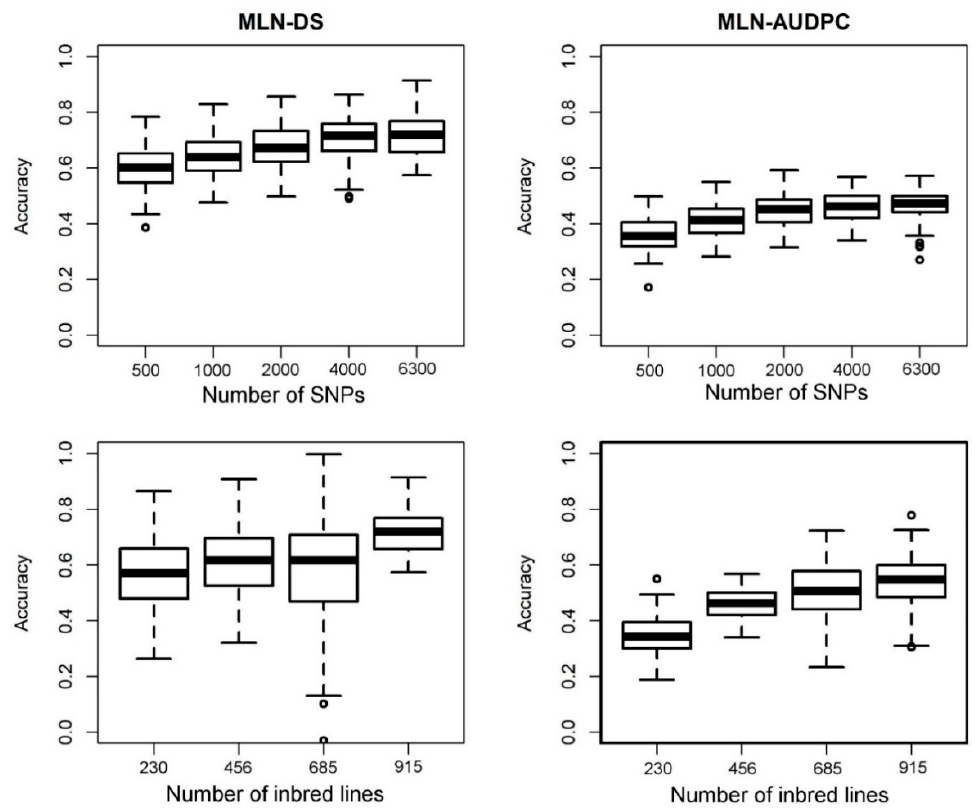
Figure 6. Effect of the number of markers and number of individuals on the accuracy of genomic prediction when the number of markers and size of the training population varied for MLN-DS and AUDPC.